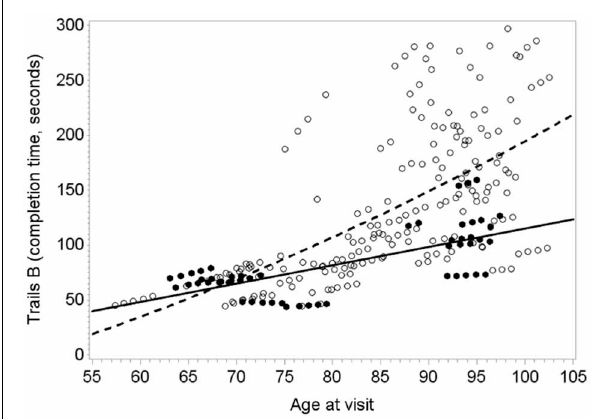
FIGURE 1 | Predicted within-person(circles) and mean trajectory (lines) of executive decline for subjects with plasma O3PUFA concentration above 110 μ g/ml (dark circles, solidline) or below this threshold(open circles, dashed line) at base line ( n = 86). Coefficient estimates calculated in the linear mixed effects model were used to predict trajectories. Participants with O3PUFA ≤ 110 μ g/ml (open circles and line) had an accelerated rate of executive decline by 2.7s per year ( β = 2.7; 95% confidence interval − 5.11 to − 0.22; age, gender, education, APOE4 , hyper tension, depression adjusted).